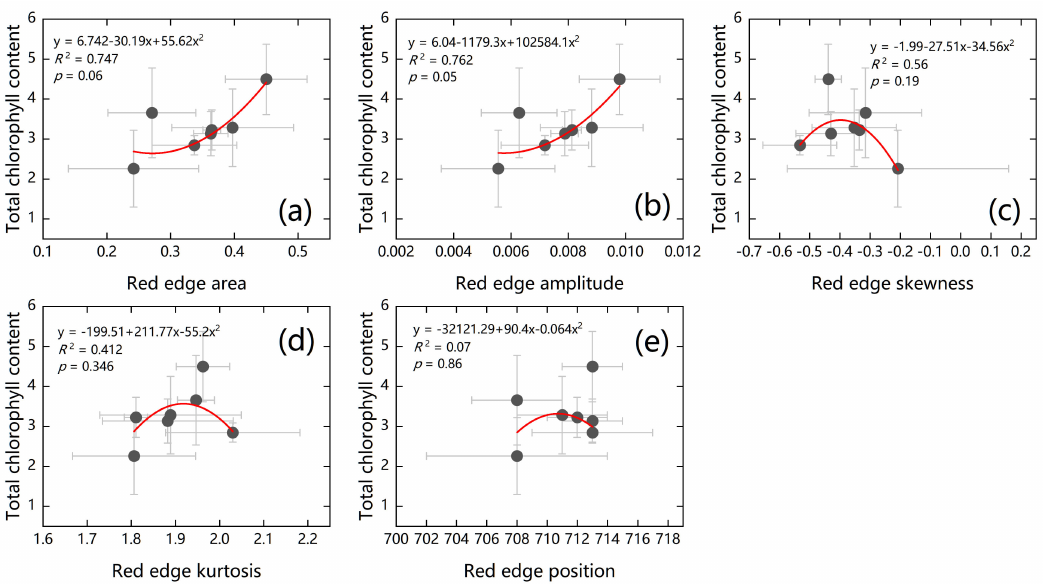
Figure 8. Relationship between total chlorophyll content of Suaeda salsa and measured red edge area ( a ), amplitude ( b ), skewness ( c ), kurtosis ( d ), position ( e ). The error bars represent the standard error of the mean of the chlorophyll and various red edge parameters (n = 3). The red curve represents a quadratic polynomial fit.